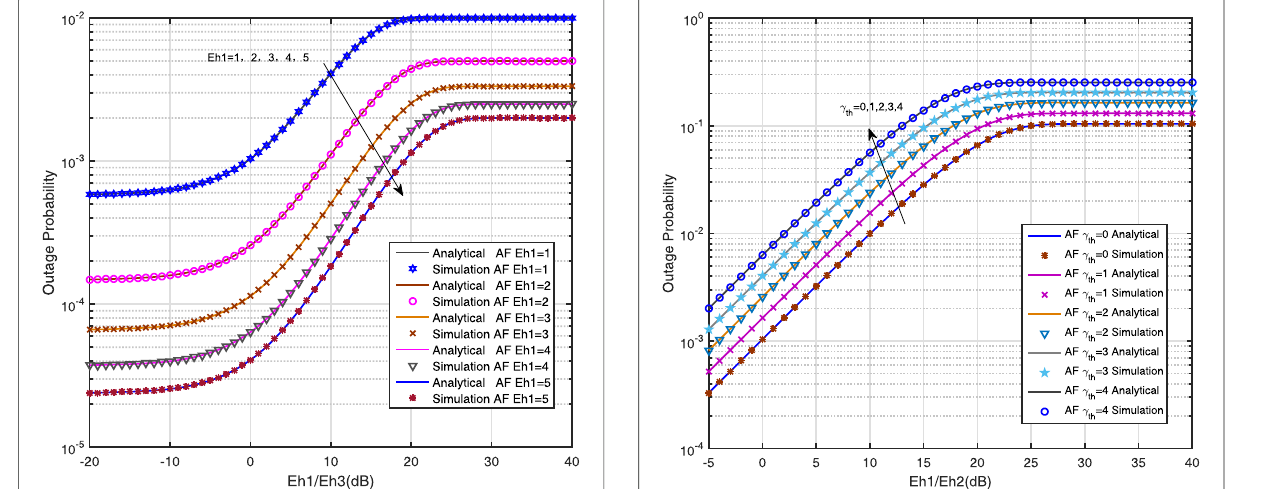
Fig. 9 Outage probability versus γ th for E h 2 = E h 3 with